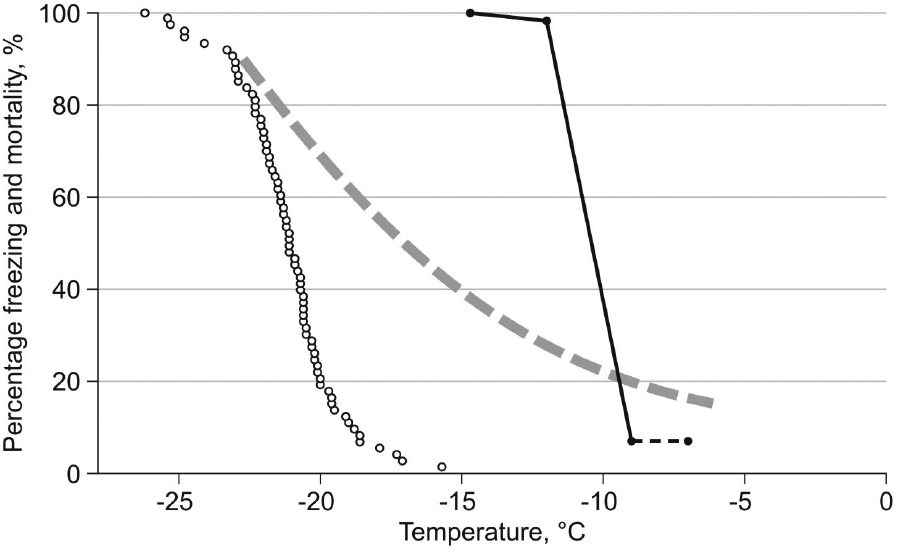
Figure 3. Cumulative values of supercooling points and mortality at negative temperatures of Telenomus tetratomus . The black line is the mortality at different temperatures (according to: Kolomiets 1961), open circles indicate the SCP obtained in our experiments, the gray dashed line indicates our predicted mortality.